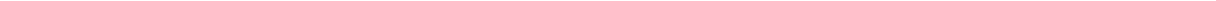
Fig. 1 iNKT cells are skewed to NKT1 phenotype in SKG ZAP70 mutant mice. a Gene set enrichment analysis of 216 TCR signaling pathway-related genes comparing the transcriptomes of thymic NKT1 and NKT2 cells from BALB/c mice. b Differentially expressed TCR pathway genes enriched in NKT1 cells from triplicate RNA-seq runs are shown in a heatmap. c – e Decreased thymic iNKT cells in SKG mice. c Representative staining of iNKT cells gated as TCR β int , CD1d- α GC tetramer + cells in live, CD8-negative thymocytes from WT and SKG mice. d Percentages and e absolute numbers of thymic iNKT cells in the WT and SKG mice. f iNKT cell subsets were gated as PLZF lo ROR γ t − (NKT1), PLZF hi ROR γ t − (NKT2), and PLZF int ROR γ t + (NKT17). g Percentages in total iNKT cells and h absolute numbers of the iNKT cell subsets in WT and SKG mice. i , j Expression of the indicated transcription factors and surface markers CXCR3 (NKT1 marker) and PD-1 (NKT2) marker in total WT or SKG iNKT cells. k Innate-like CD8 T cells, gated as Eomes + CD122 + in CD8 + CD3 ε hi thymocytes. l Absolute numbers of innate-like CD8 T cells in WT and SKG mice. m Thymic iNKT cell subsets from mixed bone marrow chimera mice. Percentages of iNKT subsets from either WT (CD45.1) or SKG (CD45.2) donors were plotted. c – m Data are representative from one of at least three independent experiments. Graphs represent mean ± SD with symbols representing individual mice. * p < 0.05; ** p < 0.01; *** p < 0.001; **** p < 0.0001; n.s. not signi fi cant (unpaired two-tailed Student ’ s t